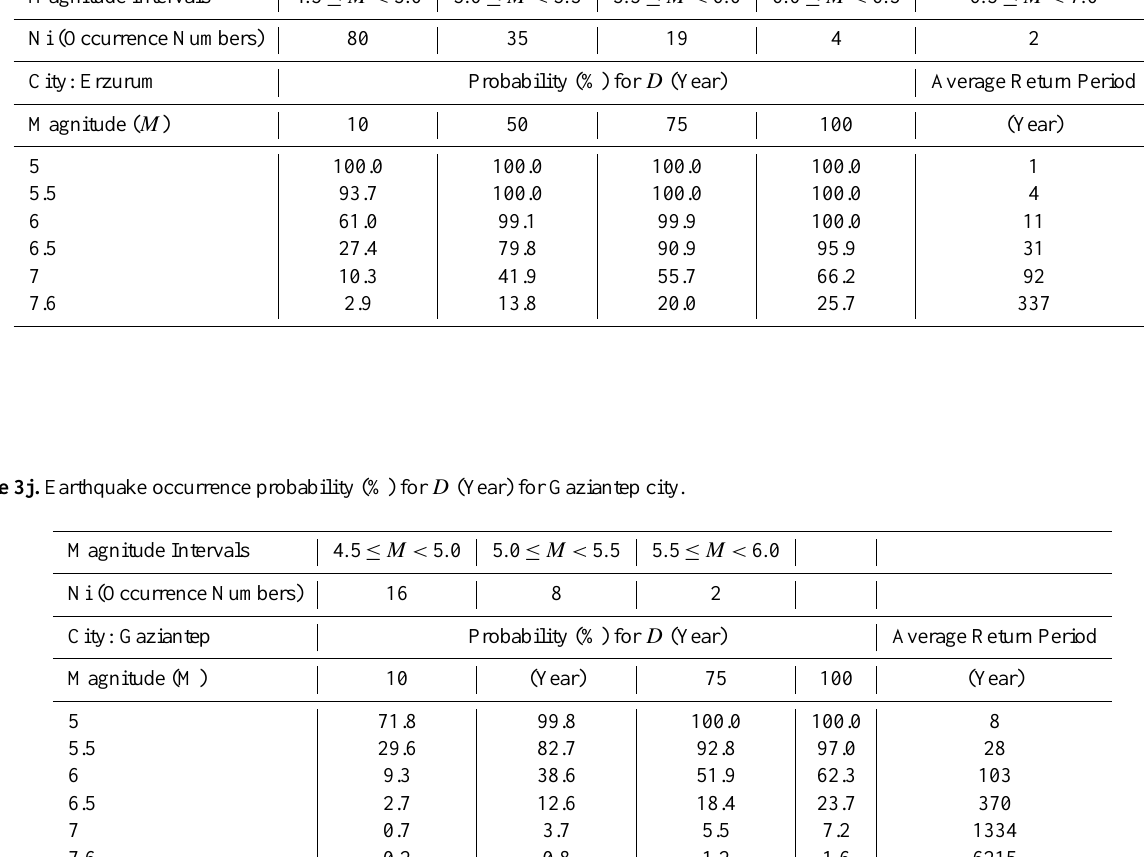
Table 3i. Earthquake occurrence probability (%) for D (Year) for Erzurum city. Magnitude Intervals